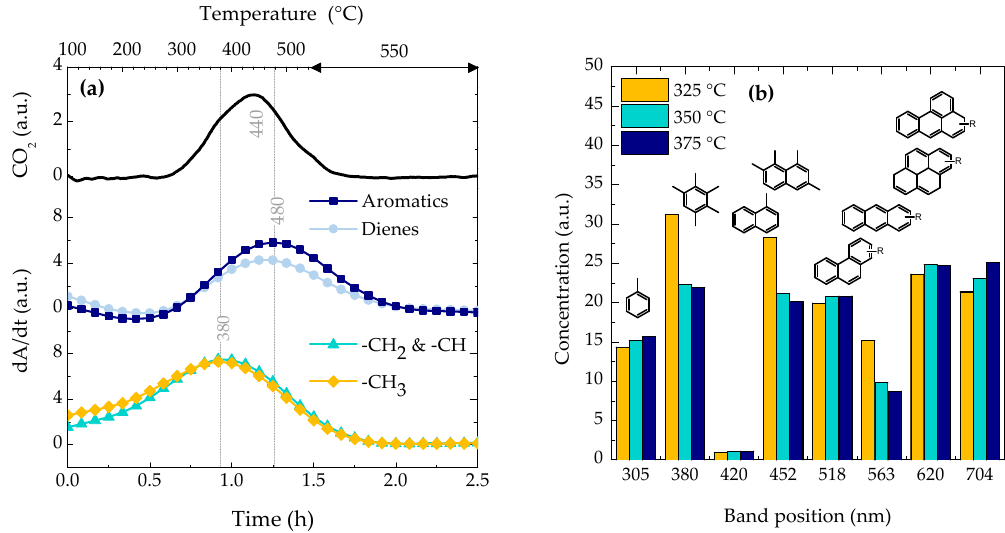
Figure 4. ( a ) Evolution of the CO 2 signal (MS) and the composition of the carbonaceous species remained in the solid (by means of FTIR spectroscopic bands) during the TPO experiment of the deactivated catalyst at 325 °C. ( b ) Concentration of the carbonaceous species trapped inside the deactivated catalyst (by means of UV-vis spectroscopy) at 325, 350 and 375 °C.